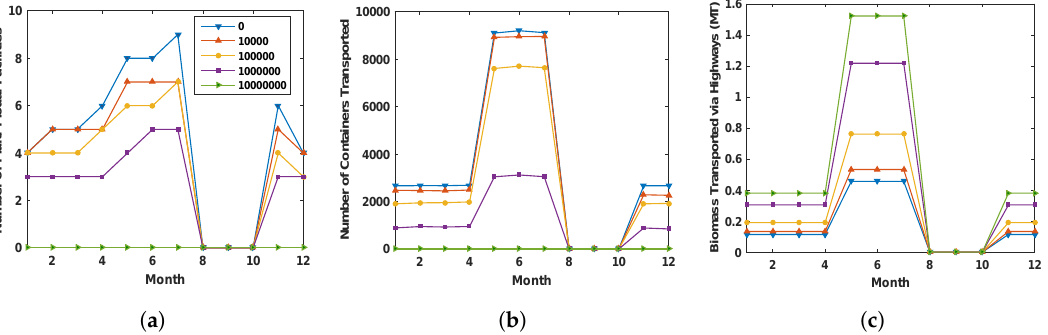
Figure 5. Impact of different congestion cost on system performance. ( a ) Multi-modal facilities; ( b ) Containers transported.; ( c ) Biomass shipped via